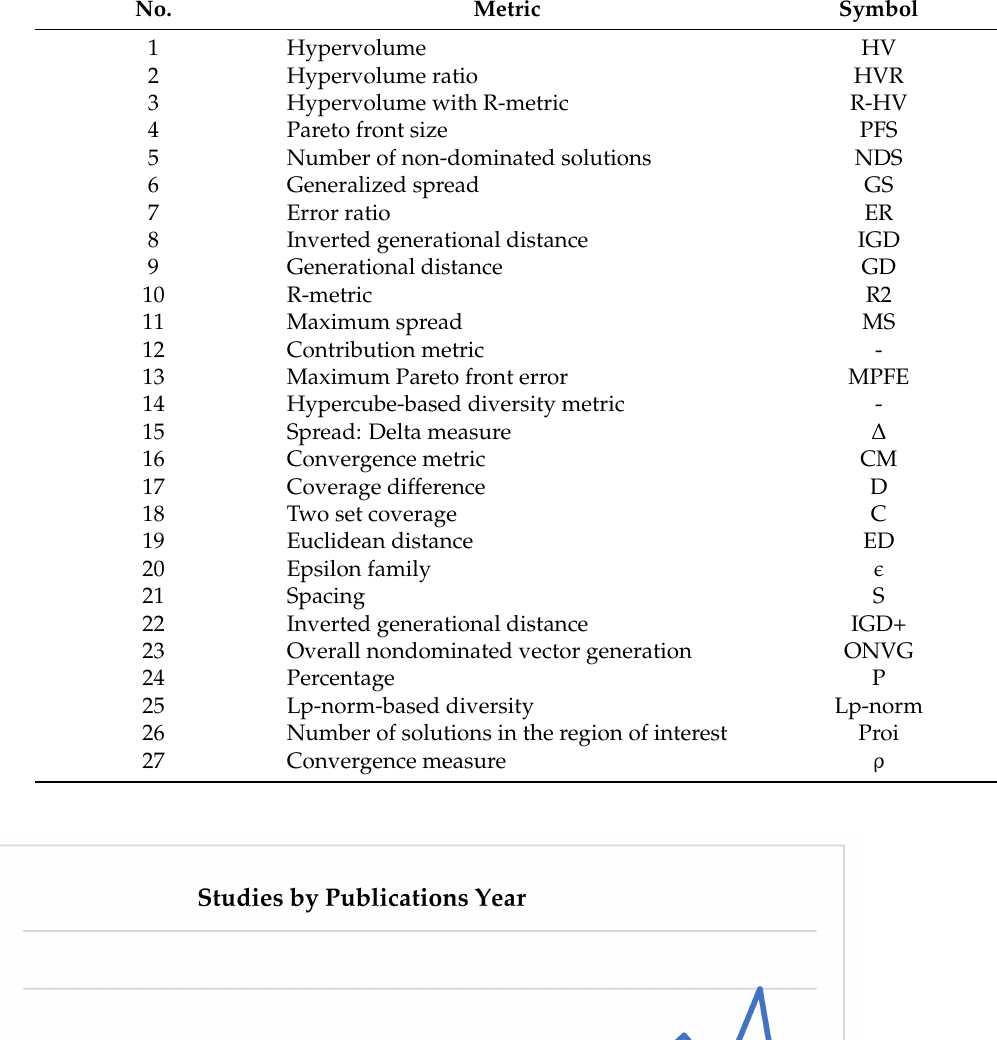
Table 2. List of performance metrics.